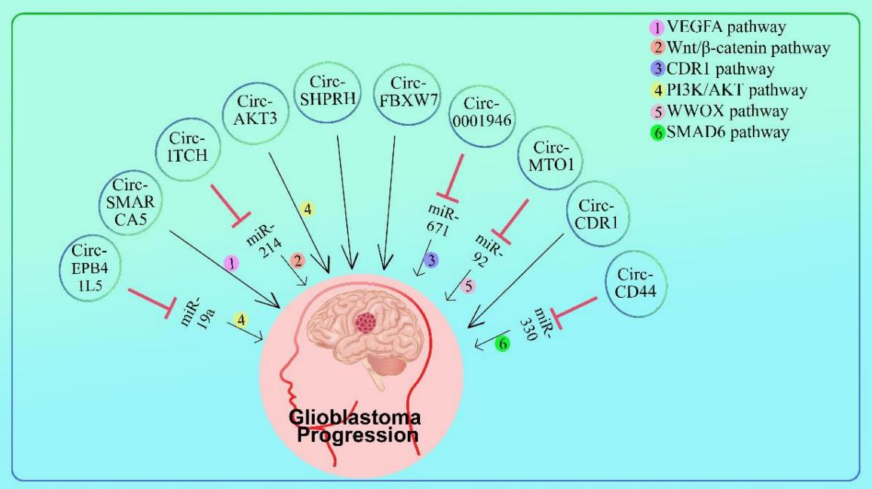
Figure 5. CircRNAs that downregulate glioblastoma growth: A schematic representation of the circRNAs involved in the regulation of glioma cell proliferation, migration, and invasion, among other functions. Numerous discovered circRNAs operate as miRNA sponges, therefore downregulating the amount of expression of the relevant target gene. These target genes or proteins further influence downstream factors involved in cancer signaling pathways by functioning as transcription factors, regulatory proteins. CircRNAs such as circ-CDC45, circ- 0029426, circ-ENTPD7, circ-FLNA, hsa- circ- 0076248, circ-0006168, circ-ABCC3, circ-LGMN, Circ-FOXO3, Hsa-circ- 0005114, Circ- 0074027, Circ-SKA3, Circ-0001801, Circ-FOXM1, Circ-NF1, Circ-MELK, Circ-NUP98, circ-ATXN1, circ-ARF1, circ-RFX3, and circ-PIK3C2A are responsible for the down-regulation of glioblastoma growth